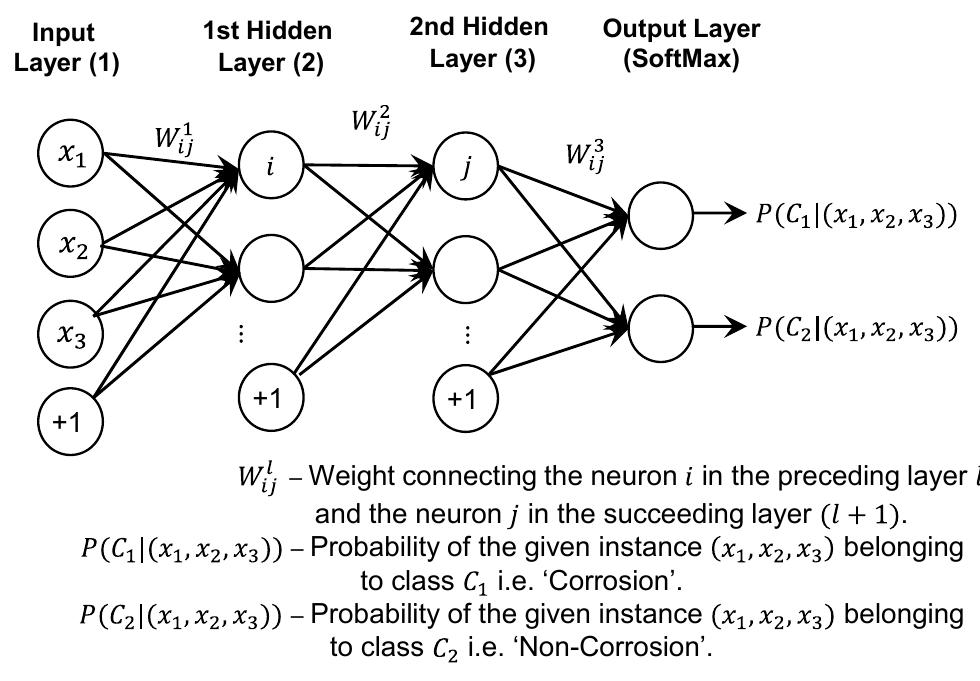
Figure 4. Schematic of a multi-layer perceptron configuration for the classification of the labeled data. Note that the input features x 1 , x 2 and x 3 represent three color features associated with ‘RGB’, ‘rgb’, ‘HSV’ and ‘La*b*’ color spaces respectively.